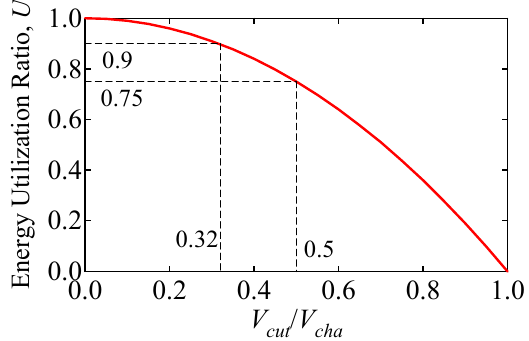
Figure 2. Energy utilization ratio U as a function of V cut / V cha . Series-parallel reconfiguration techniques, also known as changeover circuits, have been developed to cope with the above issues of EDLCs [11–18]. Literally, the series-parallel connections of EDLCs are reconfigured depending on cell voltages so that the module voltage stays within the desired voltage range. Figure 3 illustrates images of